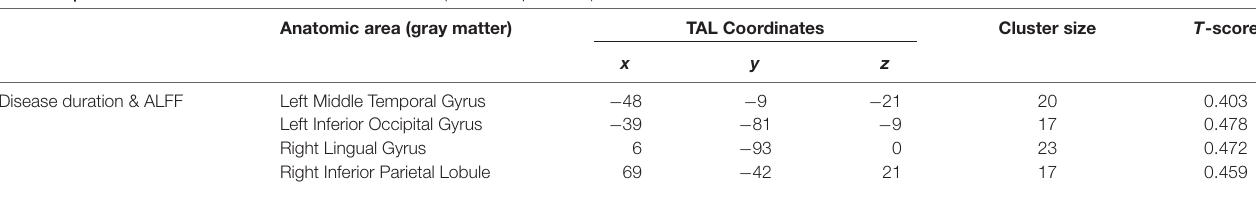
TABLE 3 | Correlation between disease duration and ALFF (corrected p <